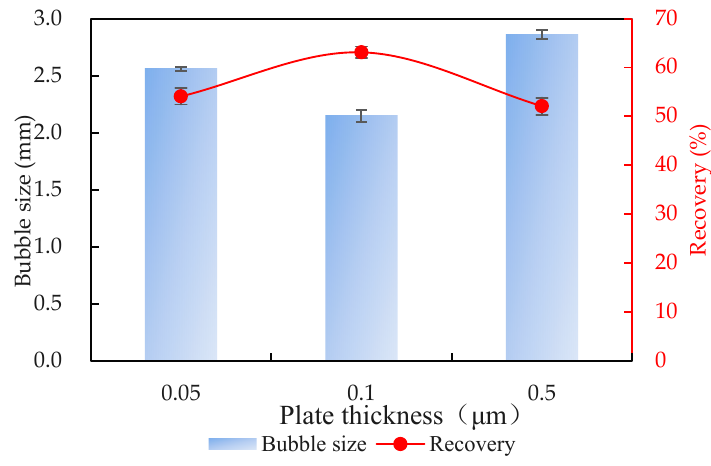
Figure 3. Effects of plate thickness on bubble size and flotation recovery.